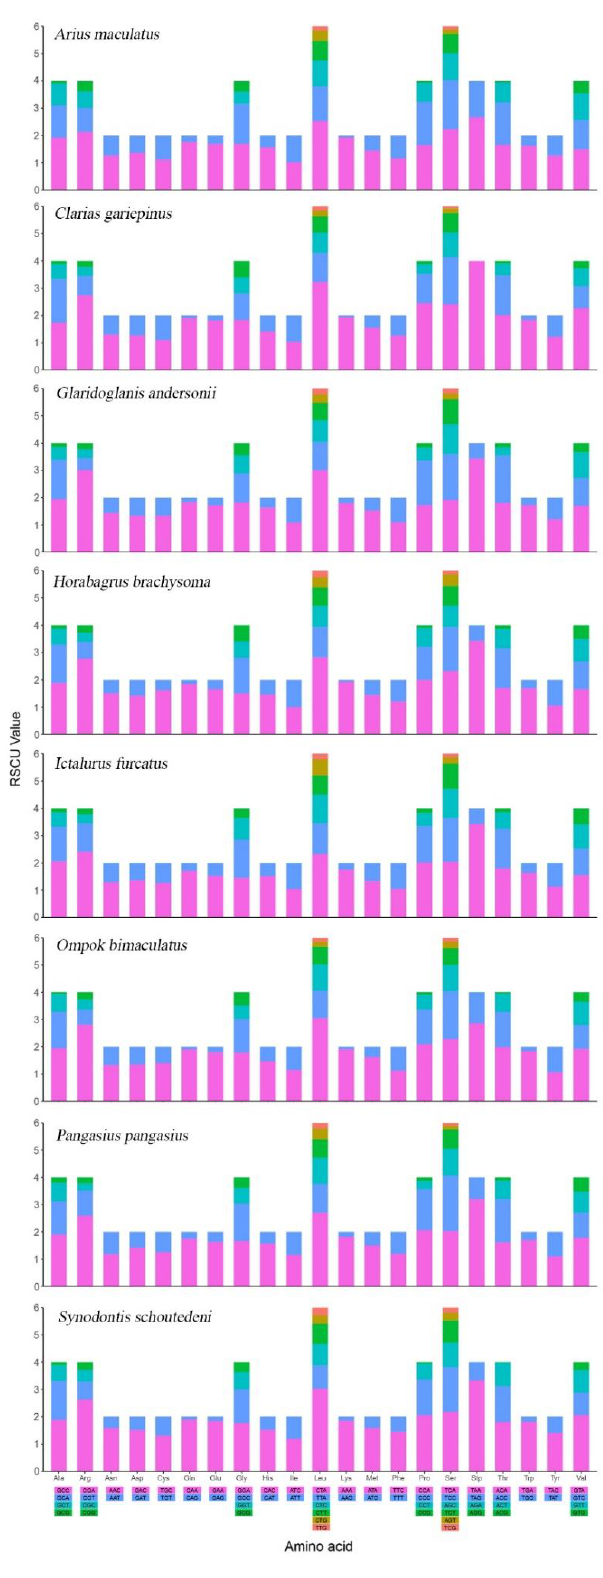
Figure 4. Relative synonymous codon usage (RSCU) of the mtDNA of 8 superfamilies in the Siluriformes. Codon families are plotted on the x-axis. Codons indicated above the bar are not present in the mtDNA.